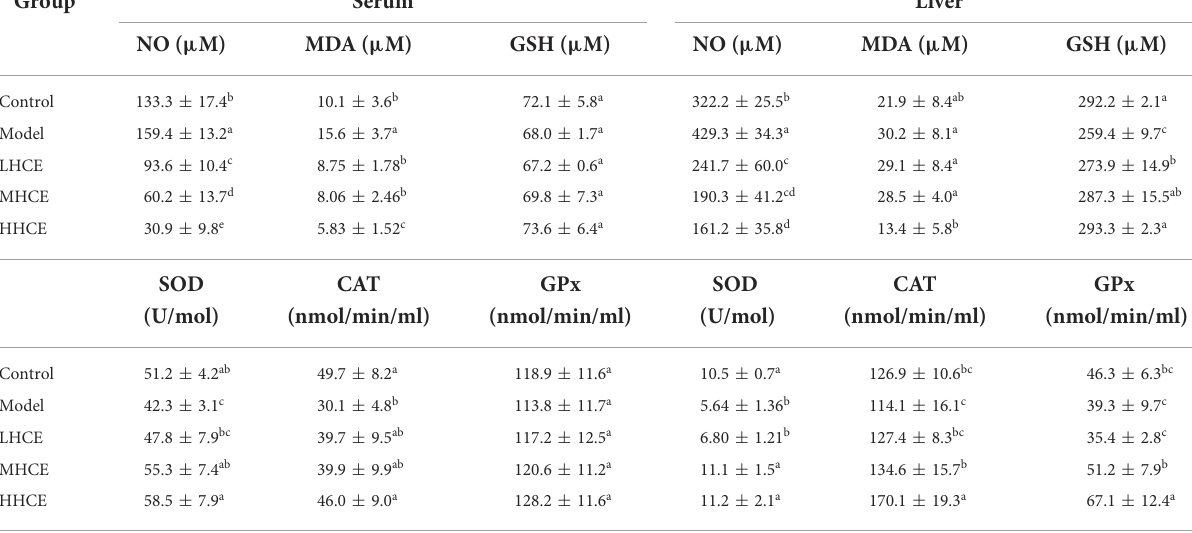
TABLE 3 Effects of different doses of herbal chicken essence (HCE) on nitric oxide (NO), GSH, and MDA levels and activities of SOD, CAT, and GPx in the serum and liver tissues of D-galactose-induced aging mice.